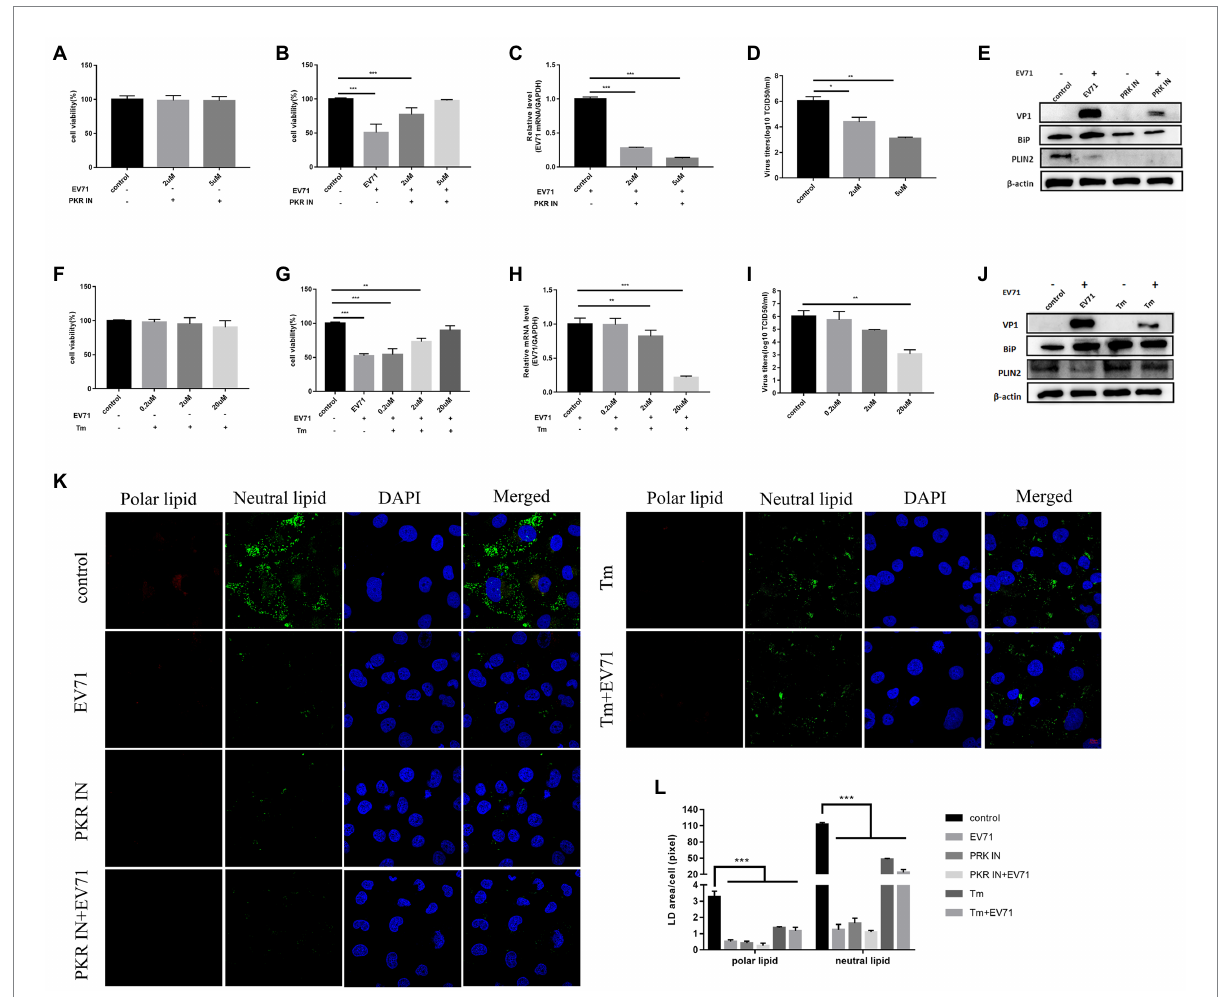
FIGURE 2 Both PKR IN and Tunicamycin inhibit the replication of EV-A71 (A) HUVECs were treated with 2 μ M and 5 μ M PKR IN for 1 h. Cell viability was detected by CCK8. (B)-(D) HUVECs were treated with 2 μ M and 5 μ M PKR IN for 1 h and then co-incubated with EV-A71 for 12 h. (B) the cell viability. (C) Total intracellular RNA was extracted and then the expression level of EV-A71 gene was detected by RT-qPCR. (D) collecting the culture supernatant to detect the virus titer. The virus titers were 2.24 × 10 4 TCID50/ml and 1.26 × 10 3 TCID50/ml after 2 μ M and 5 μ M PKR IN, respectively. (E) Detection of VP1, BiP and PLIN2 protein expression levels. Blank (1st channel), be infected with EV-A71 for 12 h (2nd channel), 5 μ M PKR IN treated HUVECs for 1 h (3rd channel) and 5 μ M PKR IN pretreated HUVECs for 1 h and then co-incubated with EV-A71 for 12 h (4th channel) VP1, BiP and PLIN2 protein expression levels. (F) HUVECs were treated with 0.2 μ M, 2 μ M and 20 μ M of Tm for 12 h, then cell viability was detected by CCK8. (G)–(I) HUVECs were treated with 0.2 μ M, 2 μ M, and 20 μ M Tm for 12 h and then incubated with EV-A71 for 12 h. (G) the cell viability. (H) the extraction of total intracellular RNA, the gene expression levels of EV-A71 were detected by RT-qPCR. (I) collecting the culture supernatant to detect the virus titer. The virus titers of the 0.2 μ M, 2 μ M, and 20 μ M were 5.50 × 10 5 TCID50/ml, 7.76 × 10 4 TCID50/ml, and 1.16 × 10 3 TCID50/ml, respectively. (J) Detection of VP1, BiP, and PLIN2 protein expression levels. Blank (1st channel), be infected with EV-A71 for 12 h (2nd channel), 20 μ M Tm treated HUVECs for 1 h (3rd channel) and 20 μ M Tm pretreated HUVEC cells for 1 h and then co-incubated with EV-A71 for 12 h (4th channel). (K) Lipid droplet expression was decreased after PKR IN and Tunicamycin treatment. Nile Red staining was used to observe the expression levels of polar and neutral lipid. Control (Cell culture 12 h), EV-A71 (be infected with EV-A71 for 12 h), PKR IN (5 μ M PKR IN treated for 1 h), PKR IN+EV-A71 (5 μ M PKR IN pretreated for 1 h and incubated with EV-A71 for 12 h), Tm (20 μ M Tm treated for 12 h), Tm + EV-A71 (20 μ M of Tm pretreated for 12 h and incubated with EV-A71 for 12 h). (L) The lipid droplet area of each cell was quantitatively calculated. All the experiments were carried out in triplicate. Error bars represent SEM. * means p < 0.05, ** means p < 0.01, *** means p <